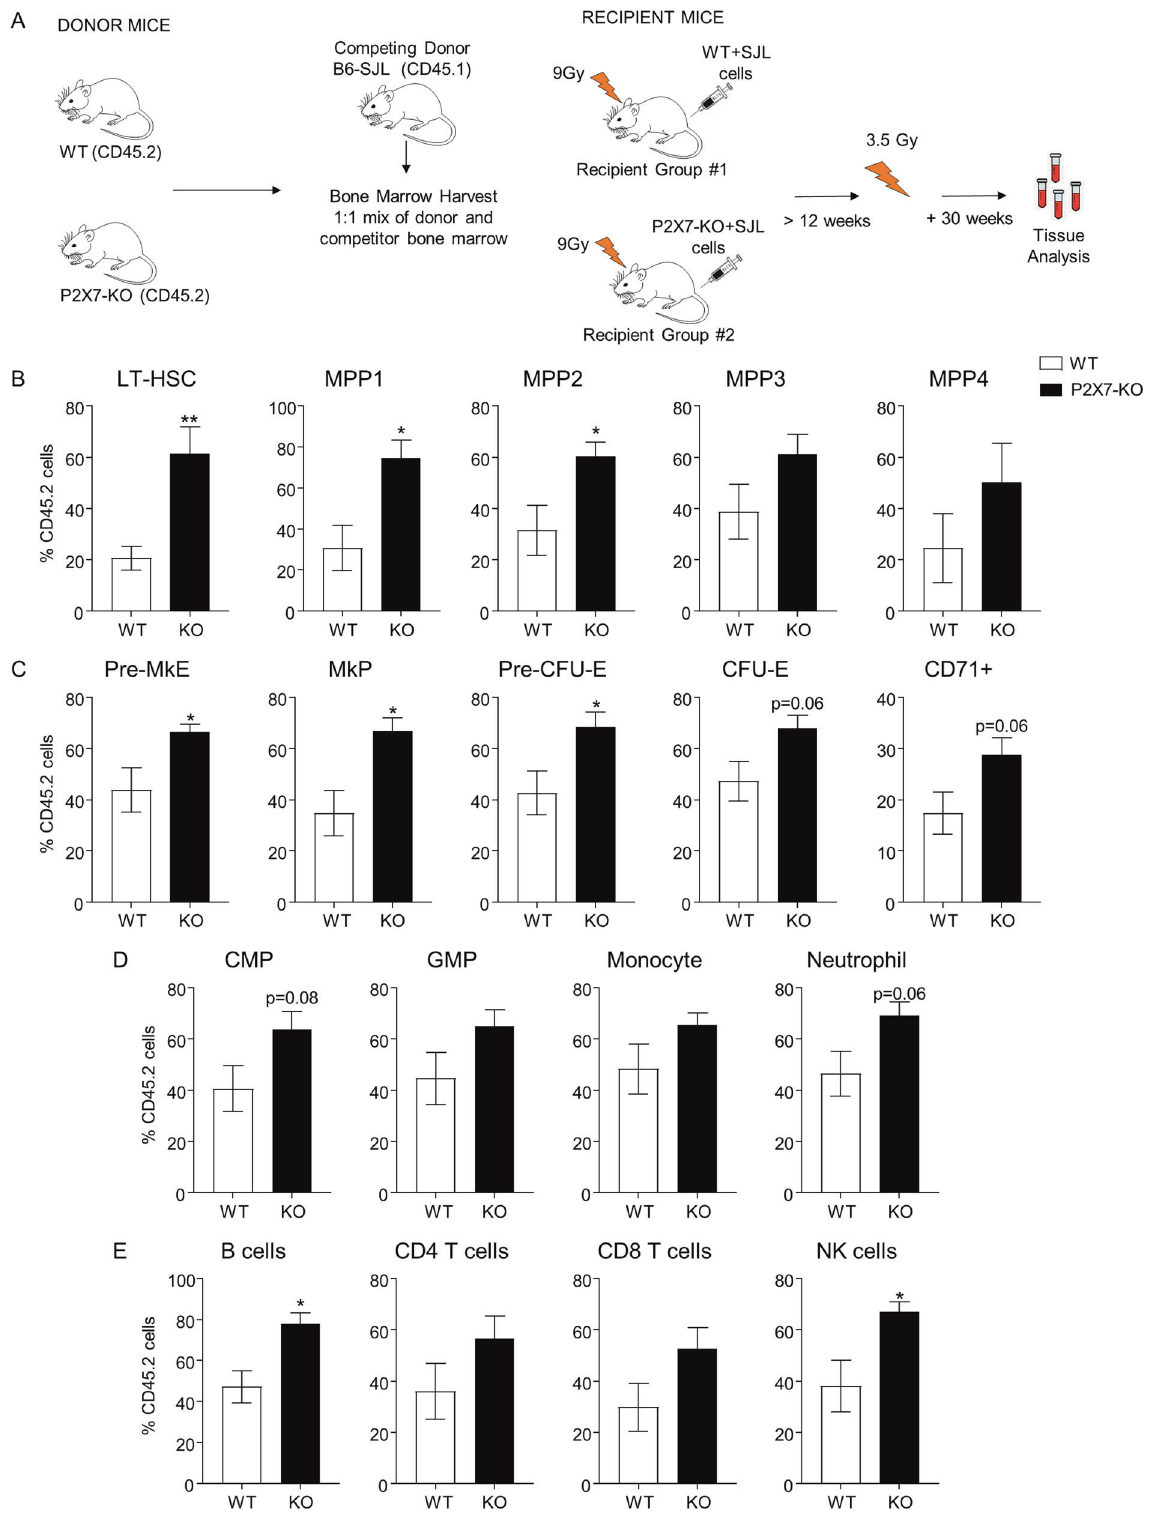
RNA sequencing The protocols were as previously described [28, 32]. Brie fl y, RNA was isolated using the MagMAX Total RNA Kit (Ambion, Life Technologies) and quality assessed using Bioanalyzer RNA Pico chips (Agilent). rRNA depletion and library preparation were performed using the SMARTer Stranded RNA-Seq Kit (Takara Clontech). The libraries were sequenced on an Illumina HiSeq